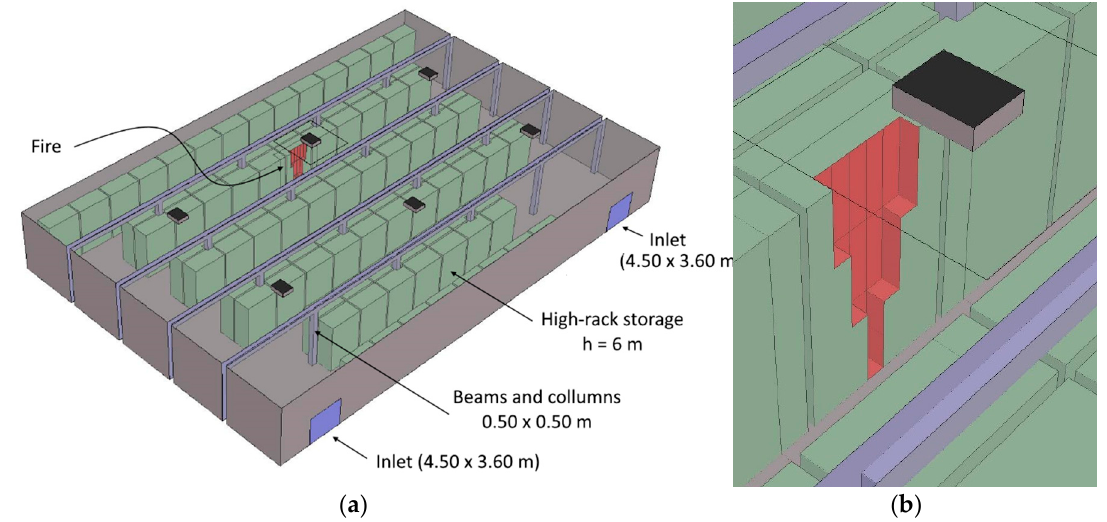
Figure 1. ( a ) The numerical model of a high-storage facility, open natural ventilator (top left), and ( b ) the detailed view on the source of fire and closed ventilator.